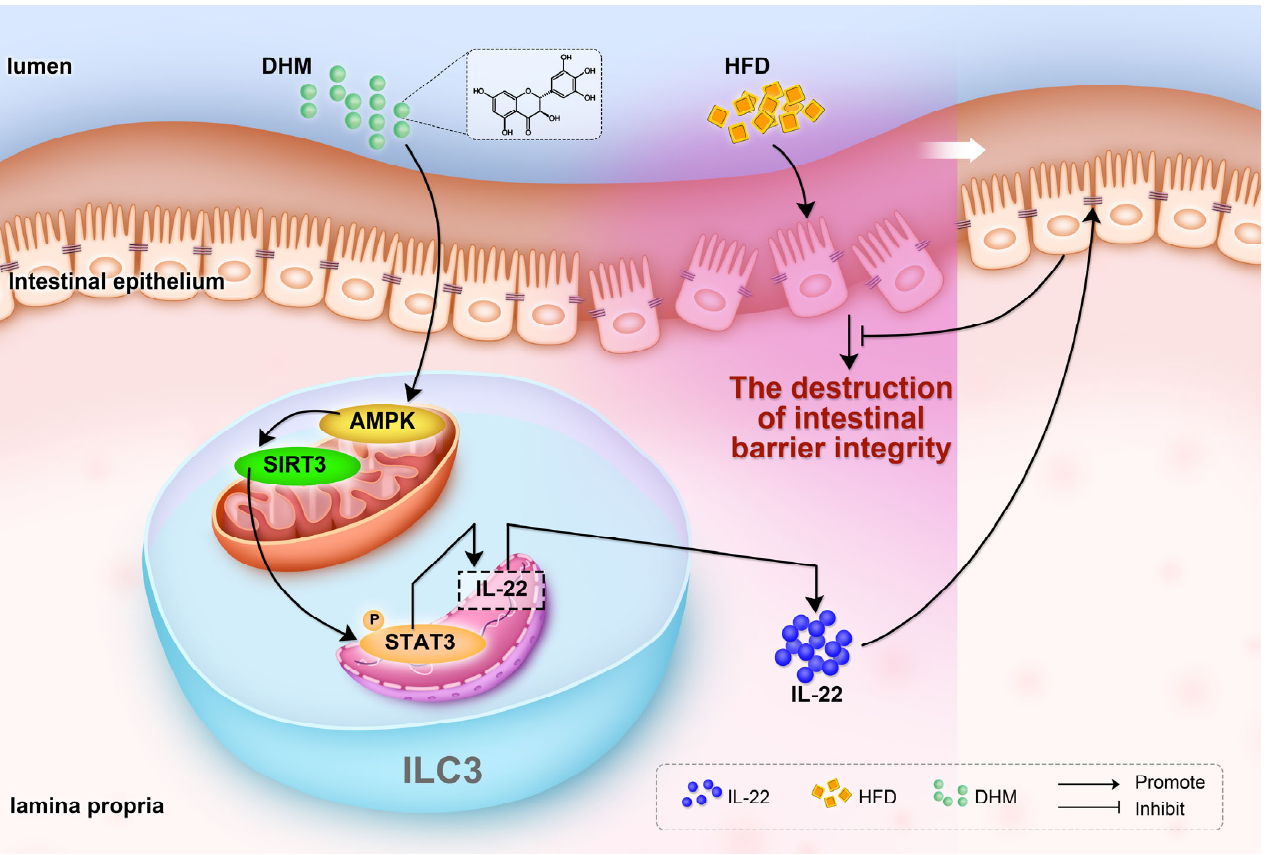
Figure 6. Model of DHM ‐ mediated protective effects against HFD ‐ induced intestinal barrier dysfunction.